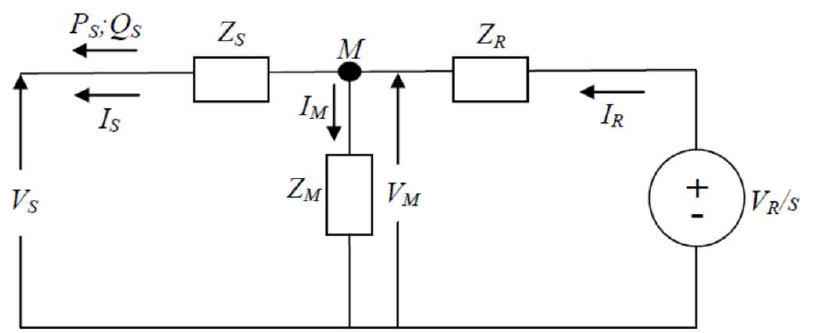
Figure 2. Equivalent circuit of DFIG.